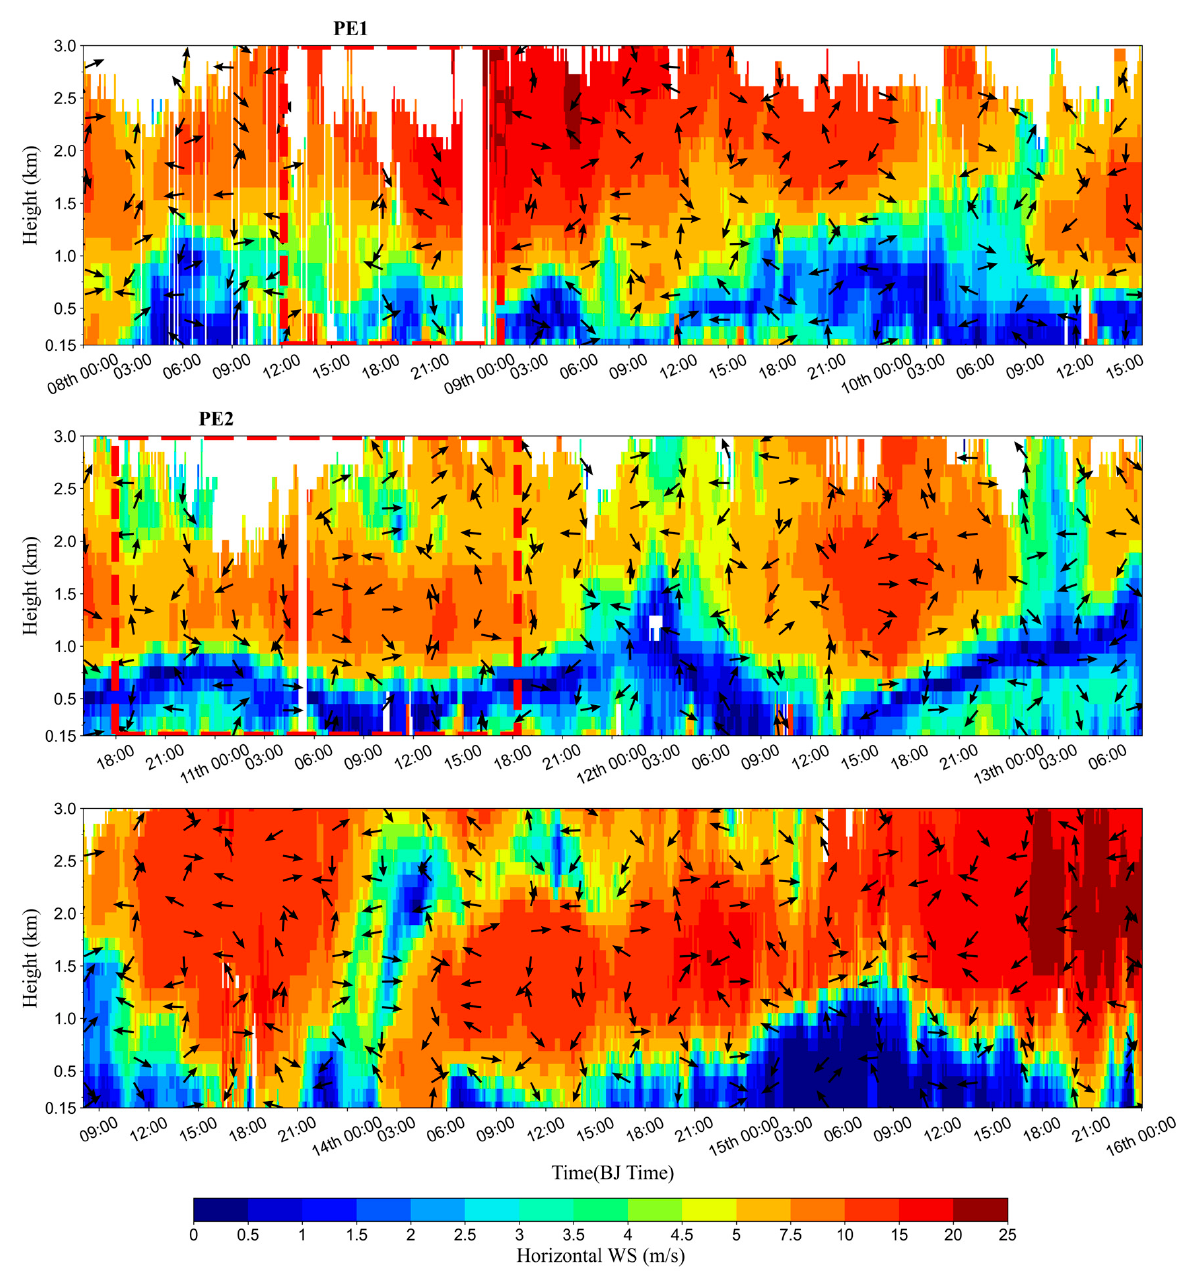
Figure 6. Horizontal wind speed (WS) in urban Beijing from 8 to 15 February 2020. Arrows indicate the wind direction.